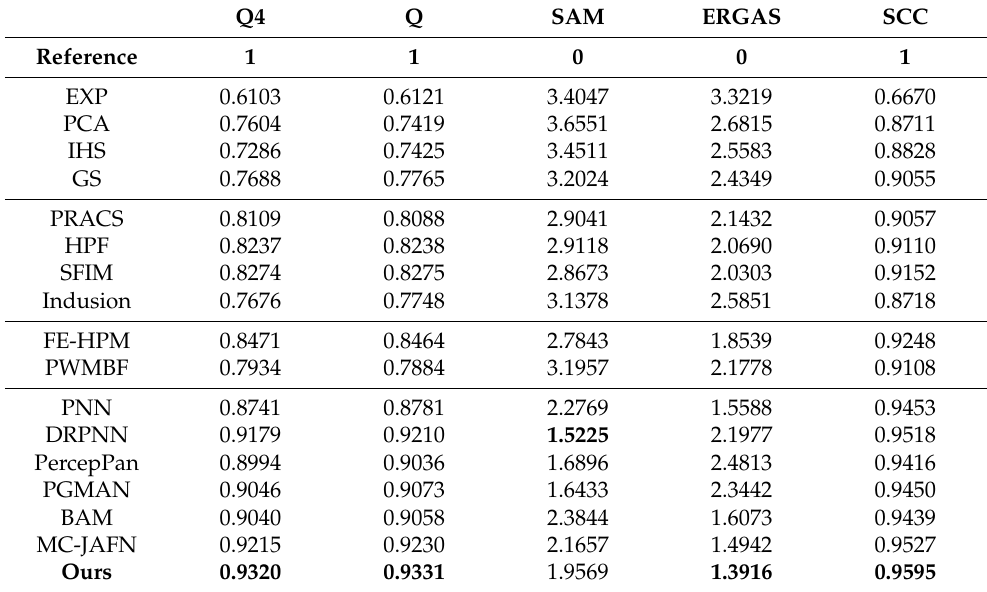
Table 2. Quantitative Evaluation for Reduced IKONOS Dataset. The Best Results are Shown in Bold .